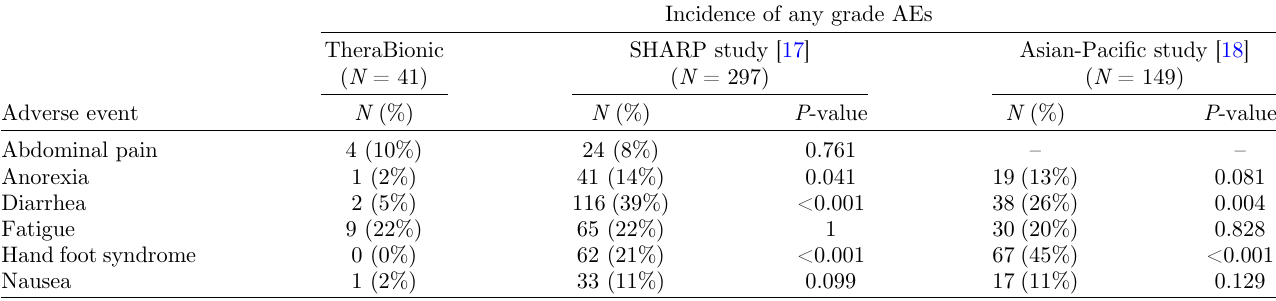
Table 8. Adverse Events Summary – Comparison to Sorafenib Trials. Adverse Events reported by phase I/II study patients receiving treatment with the TheraBionic device or Sorafenib (SHARP/Asian-Paci fi c). Statistical signi fi cance in adverse event incidence reported at a 0.05 signi fi cance